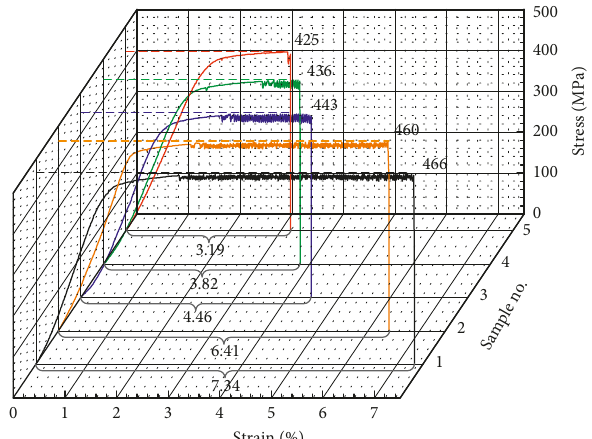
Figure 9: Tensile strength of ϕ 1.2 mm wires. Corresponding re- lationship between sample number and hydrogen content: